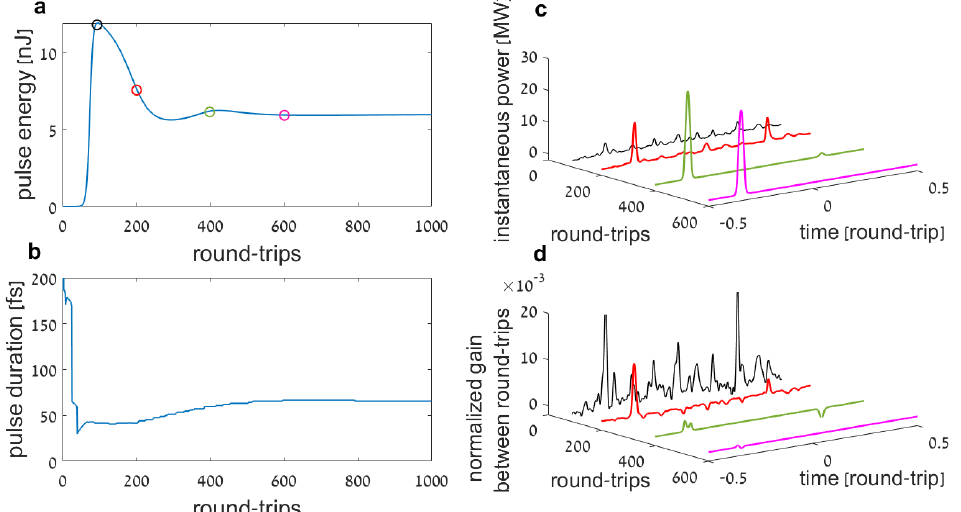
Figure 2. Evolution of the laser field during the entire oscillation buildup: ( a ) The cavity (pulse) energy and ( b ) the pulse-duration (FWHM) as a function of round-trip number (slow time scale). To observe the evolution of the pulse field within the cavity round-trip, we sampled four specific round- trips, as shown in ( c ) for the instantaneous power and ( d ) for the instantaneous gain as a function of time within a single round-trip (fast time scale). The colors of the graphs in ( c , d ) correspond to the circles on the energy graph of ( a ).